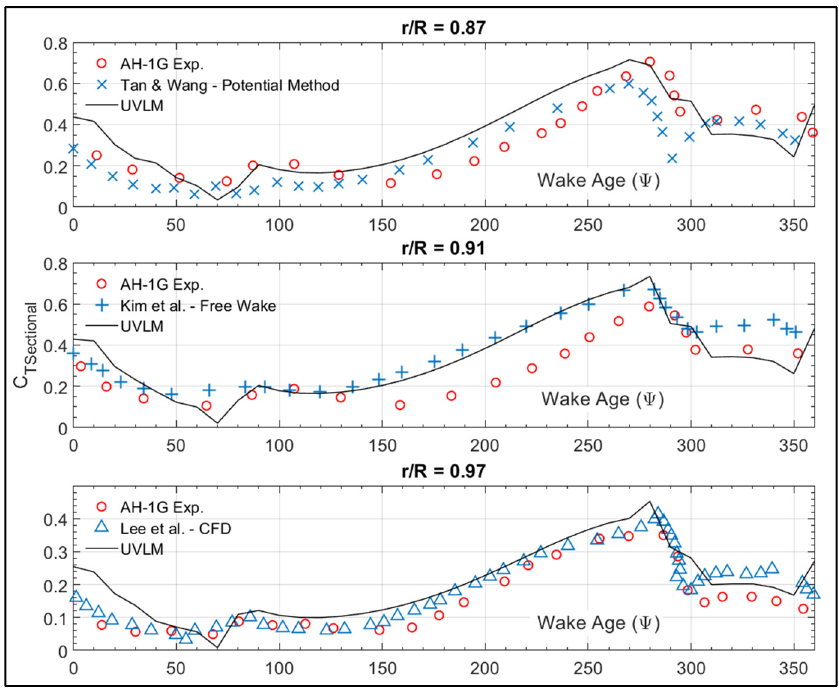
ff erent radial positions for a rotor in forward Figure 13. Sectional C T variation at different radial positions for a rotor in forward flight. Figure 13. Sectional C T variation at di